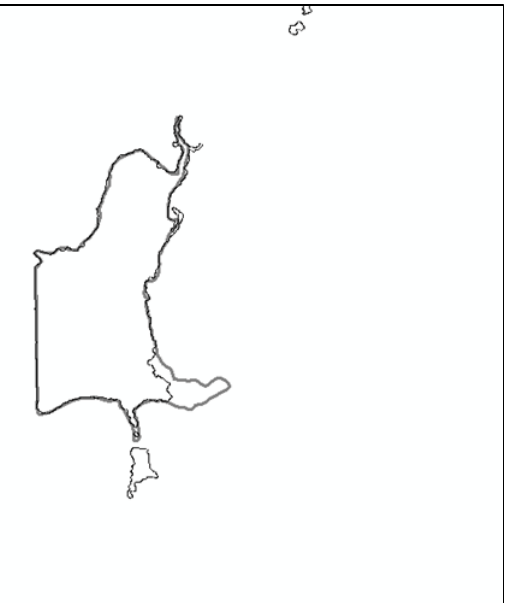
Figure 12. Comparison between break lines generated in our fully automated method (thin and dark) and break lines drawn in semi-automated method (thick and